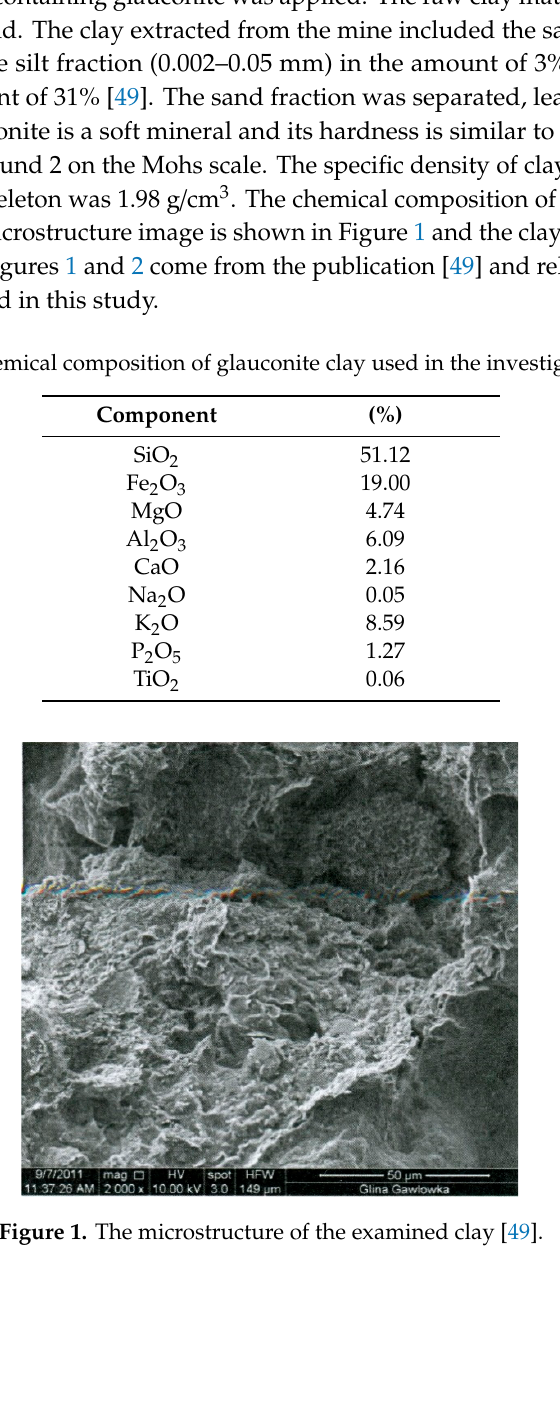
Figure 2. Clay minerals’ habit in the tested clay [49]. 2.2. Preparation of Mixture and Specimen Because of the different working properties of fresh clay mortar compared to lime or cement mortar, the procedure of mixture preparation was not based on existing standards. Before preparing the mortars, the hardened clay was dried, crushed into smaller pieces with a hammer, and then placed in pots with water. Part of the water (by mass ratio water:clay = 0.5) was added to the weighed amount of clay according to the recipe, and then the mixture was weighed and soaked to allow the clay to soften for about 12 h. After this time, the vessels with clay and water were reweighed. The remaining water was added, supplemented by the heated linseed oil varnish admixture. Heating of the varnish was conducted in order to liquefy it so that the substance could distribute more homogeneously in the mixture. Finally, the sand was added and the composite was mixed for 3 min with a mechanical agitator until a homogeneous material was obtained. The ready mortar was formed into moulds of 40 mm × 40 mm × 160 mm and stored in dry air conditions (temperature around 20 °C, relative humidity around 50%). After 5 days of ripening, the samples were demoulded and left under the same conditions until air-dried.